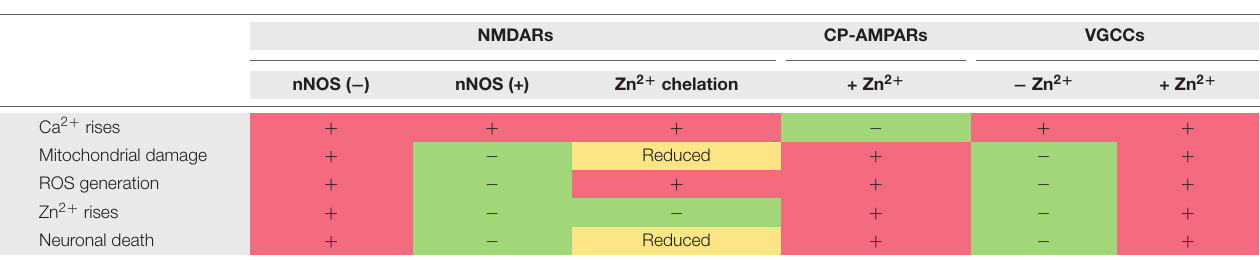
TABLE 1 | The functional hallmarks of excitotoxicity.